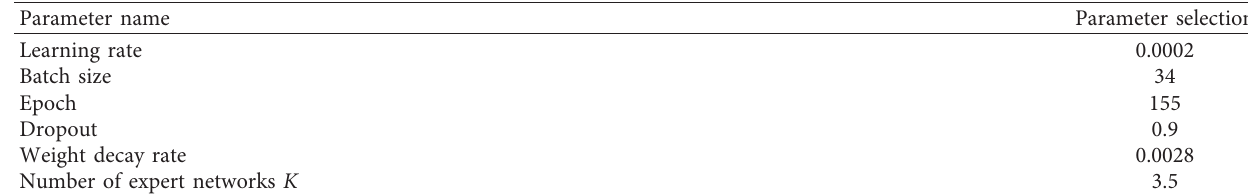
Figure 3: Multipath greedy algorithm reconstruction of the character animation synthesis flowchart. Table 1: MANN network